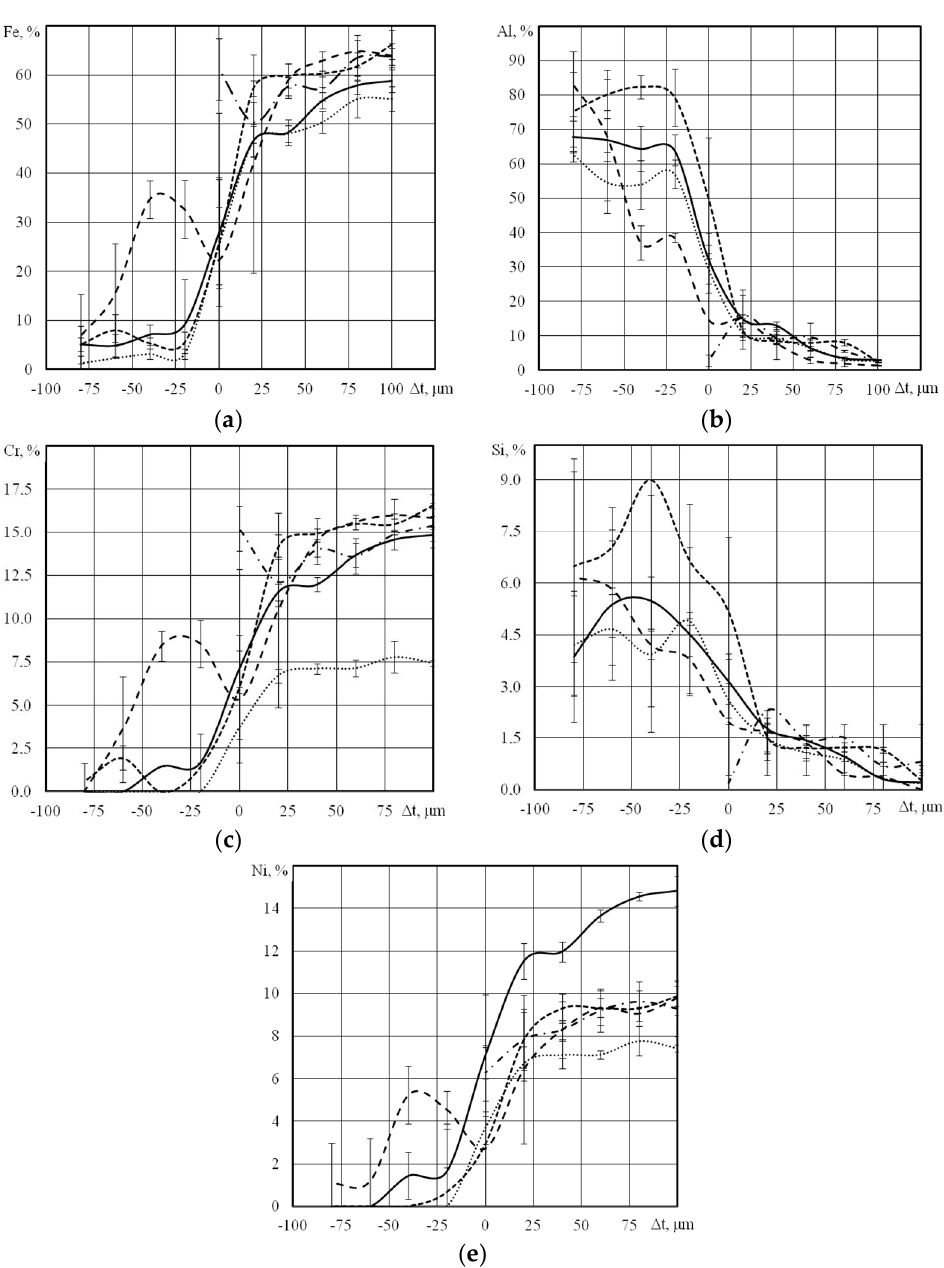
Figure 5. Distribution of chemical elements Fe ( a ), Al ( b ), Cr ( c ), Si ( d ) and Ni ( e ) at the bimetal interface zone: SLM mode 1; SLM mode 2; SLM mode 3; SLM mode 4; SLM mode 5.